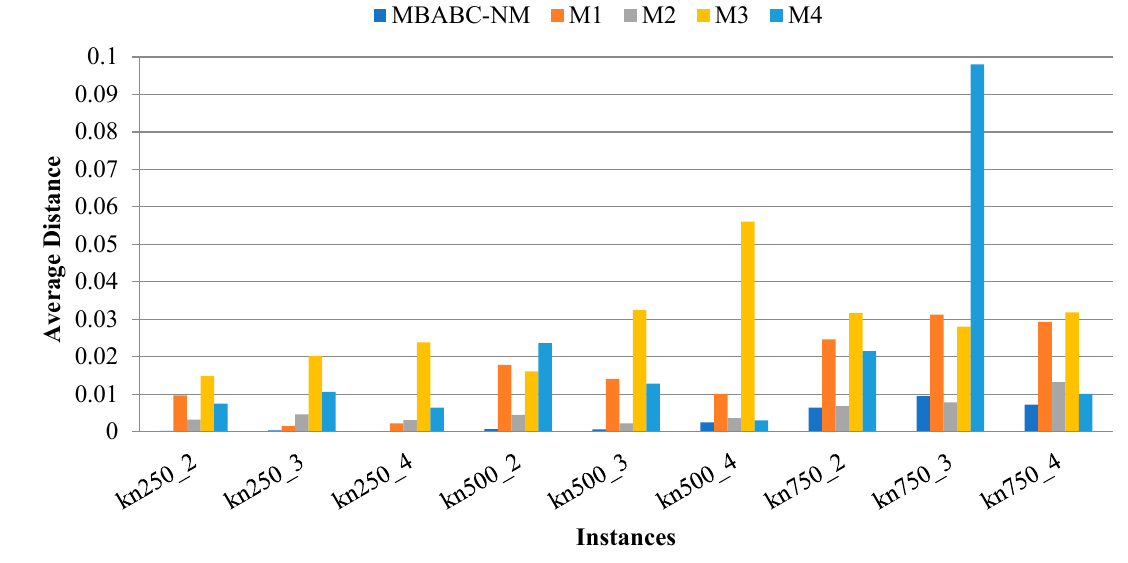
Figure 4. Performance of MBABC-NM with respect to average distance.